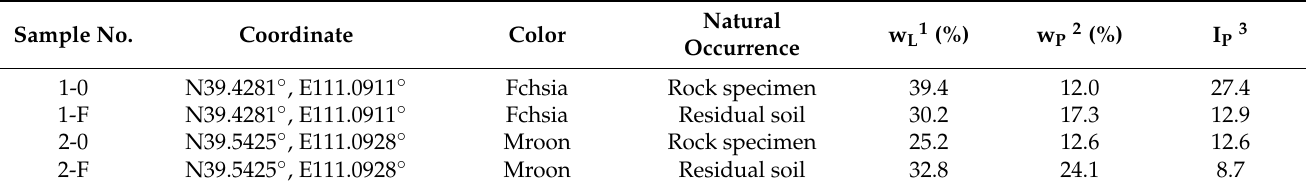
Table 3. Basic physical properties of soil samples.